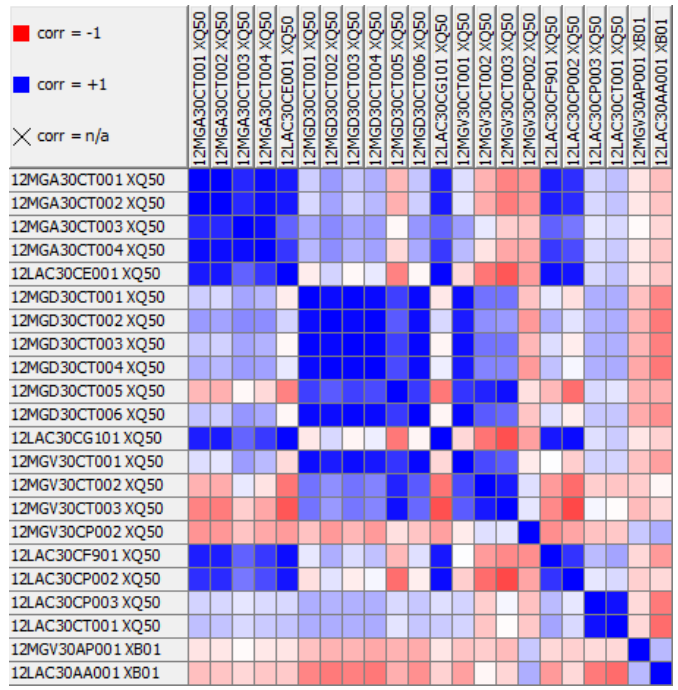
Figure 4. Correlation ( corr ) matrix for the training